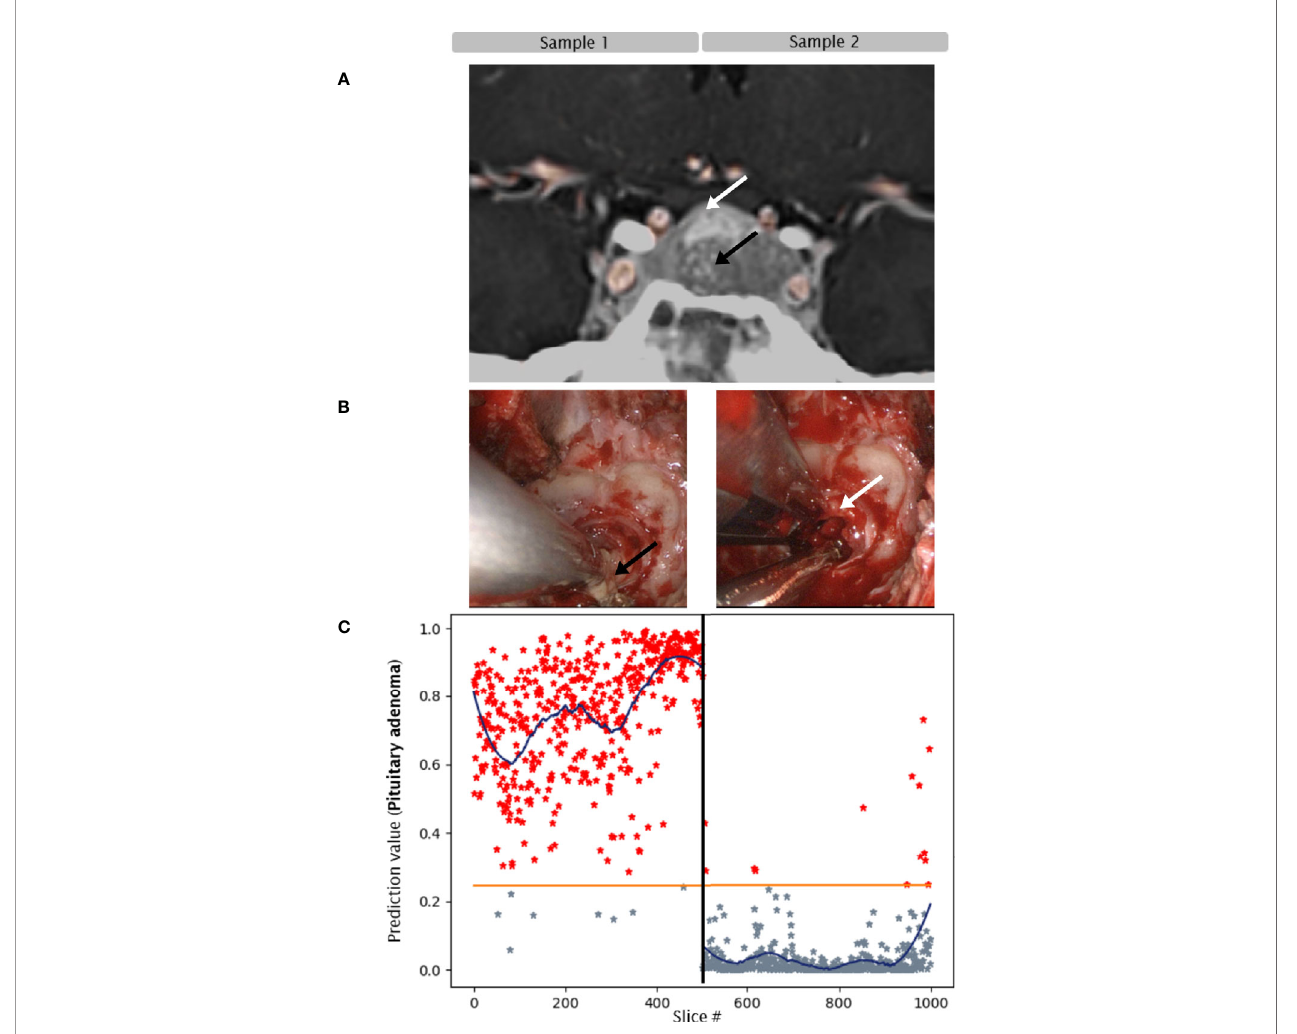
FIGURE 2 | Case 1. Convolutional neuronal network assessment of OCT images of samples of pituitary adenoma (blackarrow) andadjacent gland(white arrow). (A) MRI, 22mm macroadenoma. (B) intraoperative imaging. (C) Diagram of pituitaryadenoma probability. X axis: number of each classi fi ed slice (500 per sample).The orange line indicates the classi fi cation threshold for pituitary adenoma/non-adenoma. The blue curveindicates an average of 150 slices to visualize the network